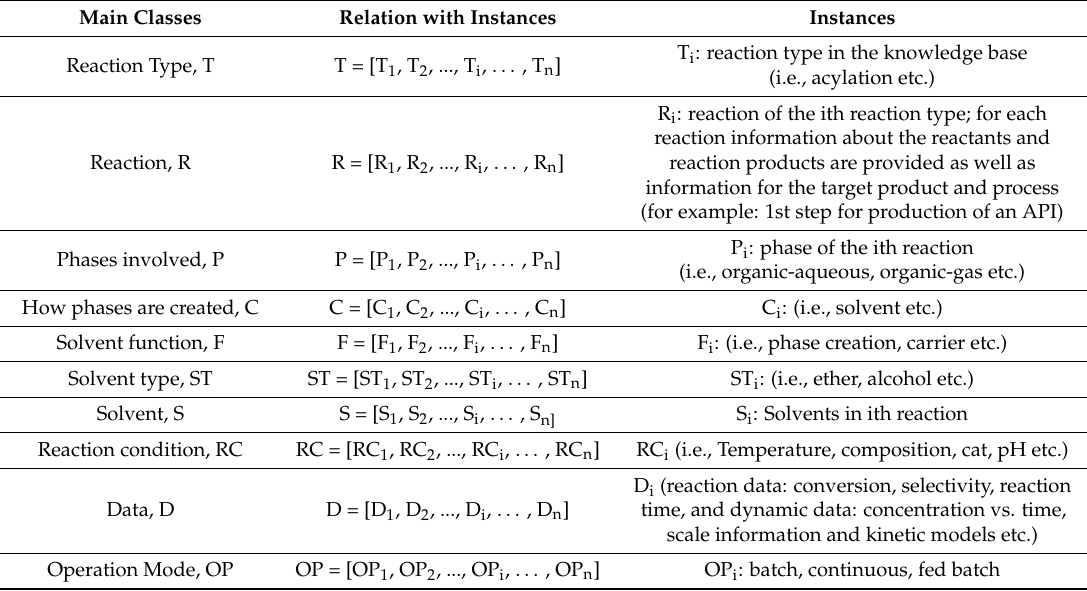
Table 4. Main classes of the reaction type database and the